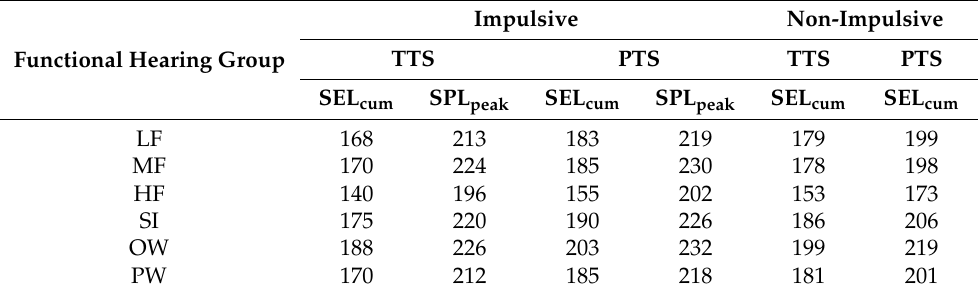
Table 1. Summary of current marine mammal onset TTS and PTS thresholds (data from [96]). SEL